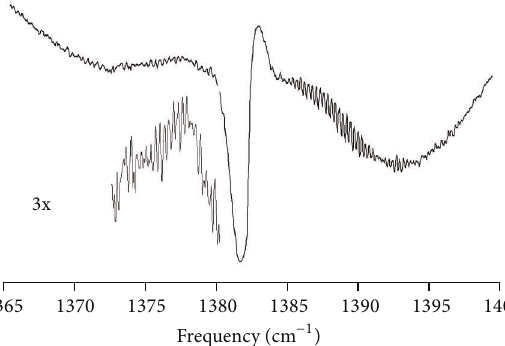
Figure 3: Low resolution FTIR spectrum of the ] 7 of isobutylene.